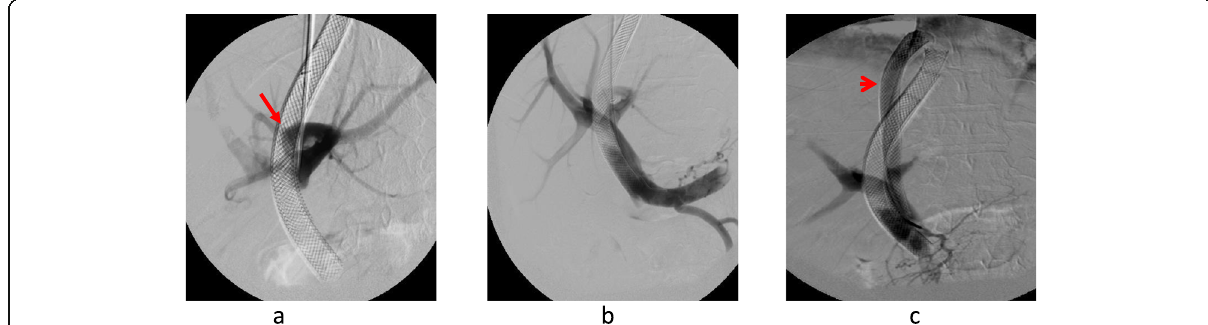
Fig. 6 Male patient with occluded standard TIPS-RPV (arrow). The left portal vein was approached followed by left portography ( a ). Then, the main portography was done to measure the pressure ( b ). Finally, the Wallstent (arrowhead) that was delivered shows a straight course between the left portal and cava with an excellent flow ( c